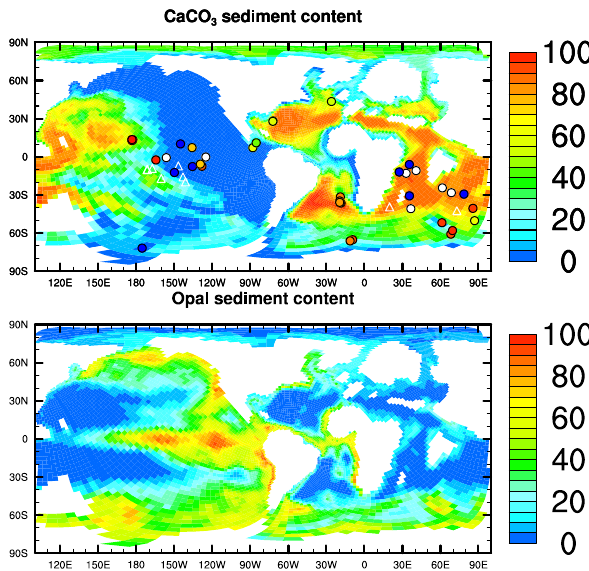
Figure 12. Sediment content of CaCO 3 and opal (both in wt%), averaged over the last 30 years of the simulation. The CaCO 3 plot includes observational data points from Panchuk et al. (2008): colored dots indicate wt%, white dots indicate that CaCO 3 is present but wt% is unknown, and triangles indicate a hiatus (due to non-deposition).